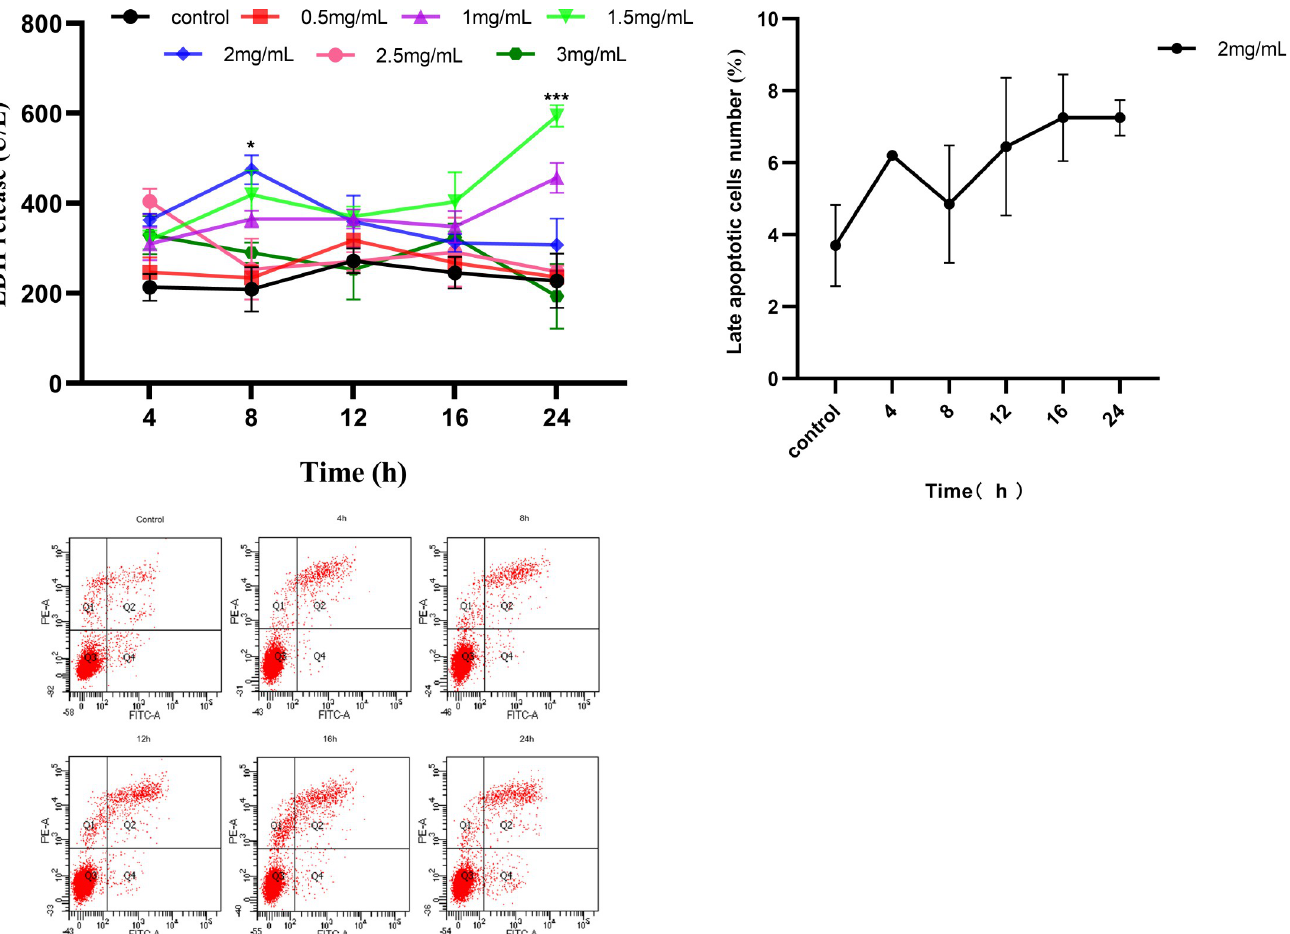
Fig 1. Determination of LDH release amount and apoptosis rate after treatment of MAC-T cells with matrine. A. MAC-T cells were treated with matrine at a series of concentrations (0.5-3mg/mL) for 4~24 h. The cell cytotoxicity was evaluated by the LDH assay. B. MAC-T cells were treated with matrine at a concentration of 2 mg/mL for 4~24h. Apoptosis detection with Annexin V-FITC/PI double staining in different groups by flow cytometry. The Q1 represents necrotic or mechanical damaged cells. The Q2 region represents late apoptotic cells. The Q3 region represents viable cells, while the Q4 region represents early apoptotic cells. C. Column bar graph of mean cell florescence for late apoptotic cells. The data are presented as the mean ± S.D. of three independent experiments ( � p < 0.05).